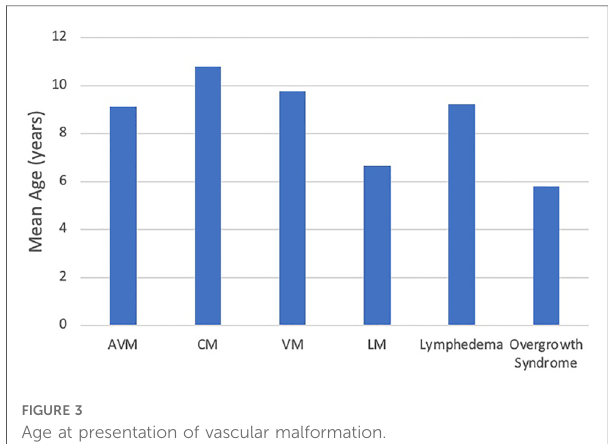
FIGURE 3 Age at presentation of vascular